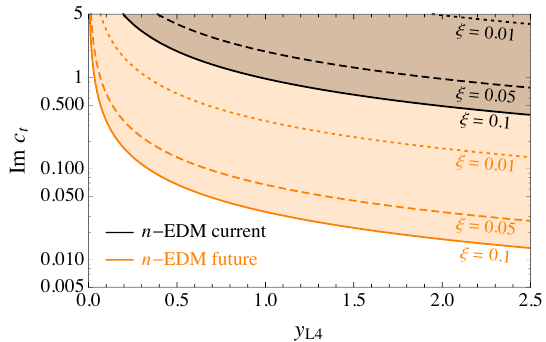
Figure 6 . Bounds on the CP-violating part of the c t coupling as a function of the y L 4 mixing derived from the current and projected constraints on the neutron EDM. The results are derived by using the constraints on the Weinberg